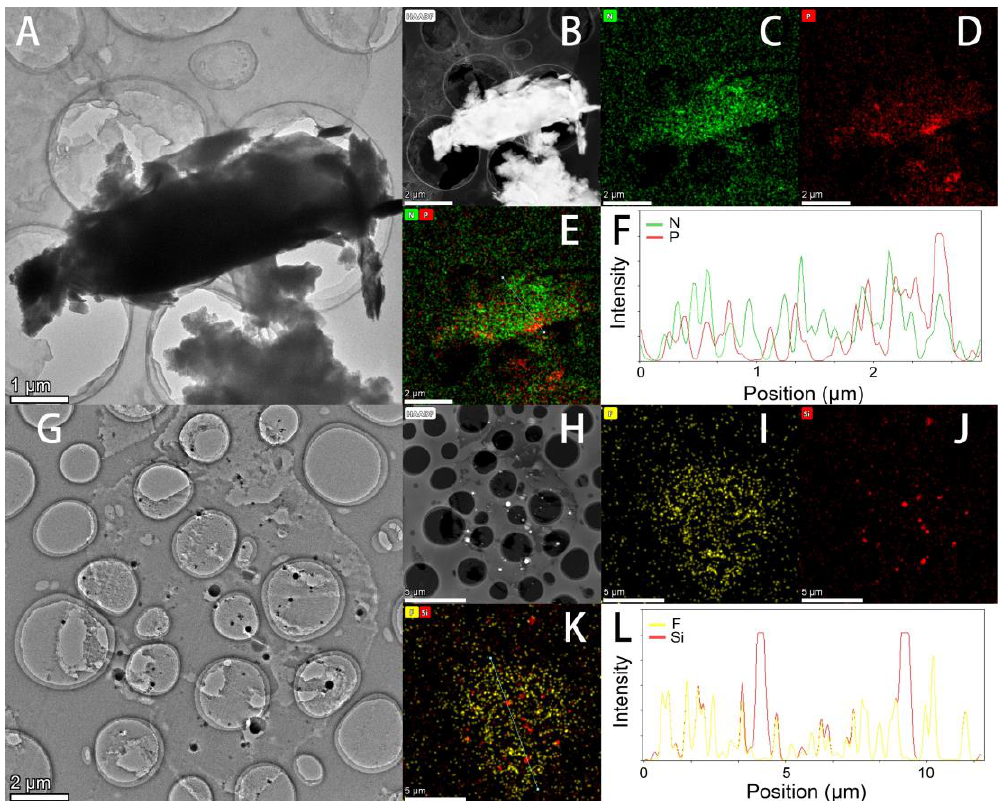
Figure 2. TEM images, HAADF images, and linear EDS plots of ultrathin cross-sections on holey carbon films: ( A, B, F ) PIL/PANI and ( G, H, L ) PIL/SiO 2 . EDS elemental maps: ( C ) N, ( D ) P, ( E ) N and P, ( I ) F, ( J ) Si, and ( K ) F and Si. ( B-E scale bar = 2 μ m, H-K scale bar = 5 μ m)